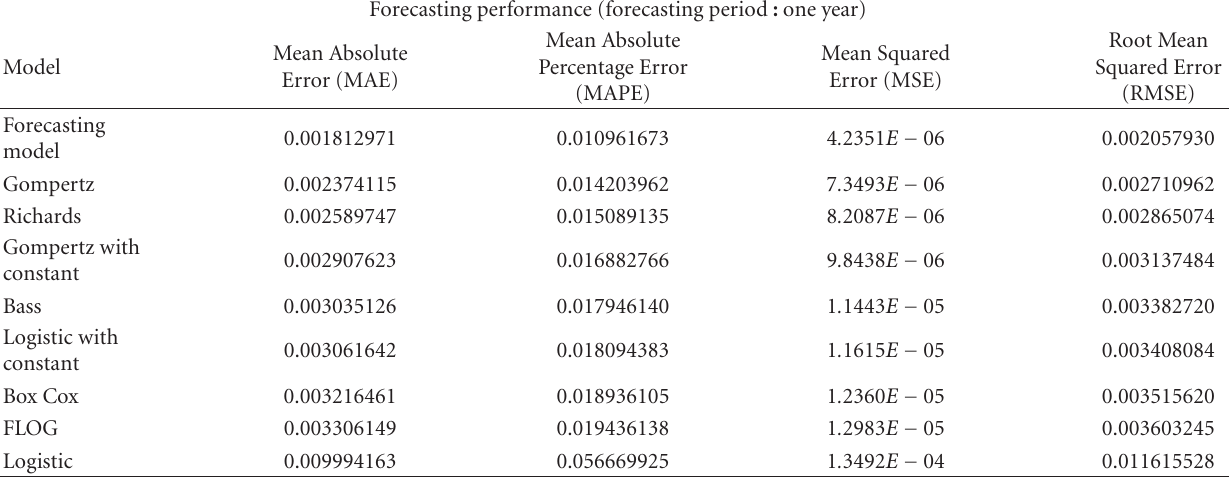
Table 2: Results of the forecasting process for the models (forecasting period: one year). Forecasting performance (forecasting period : one